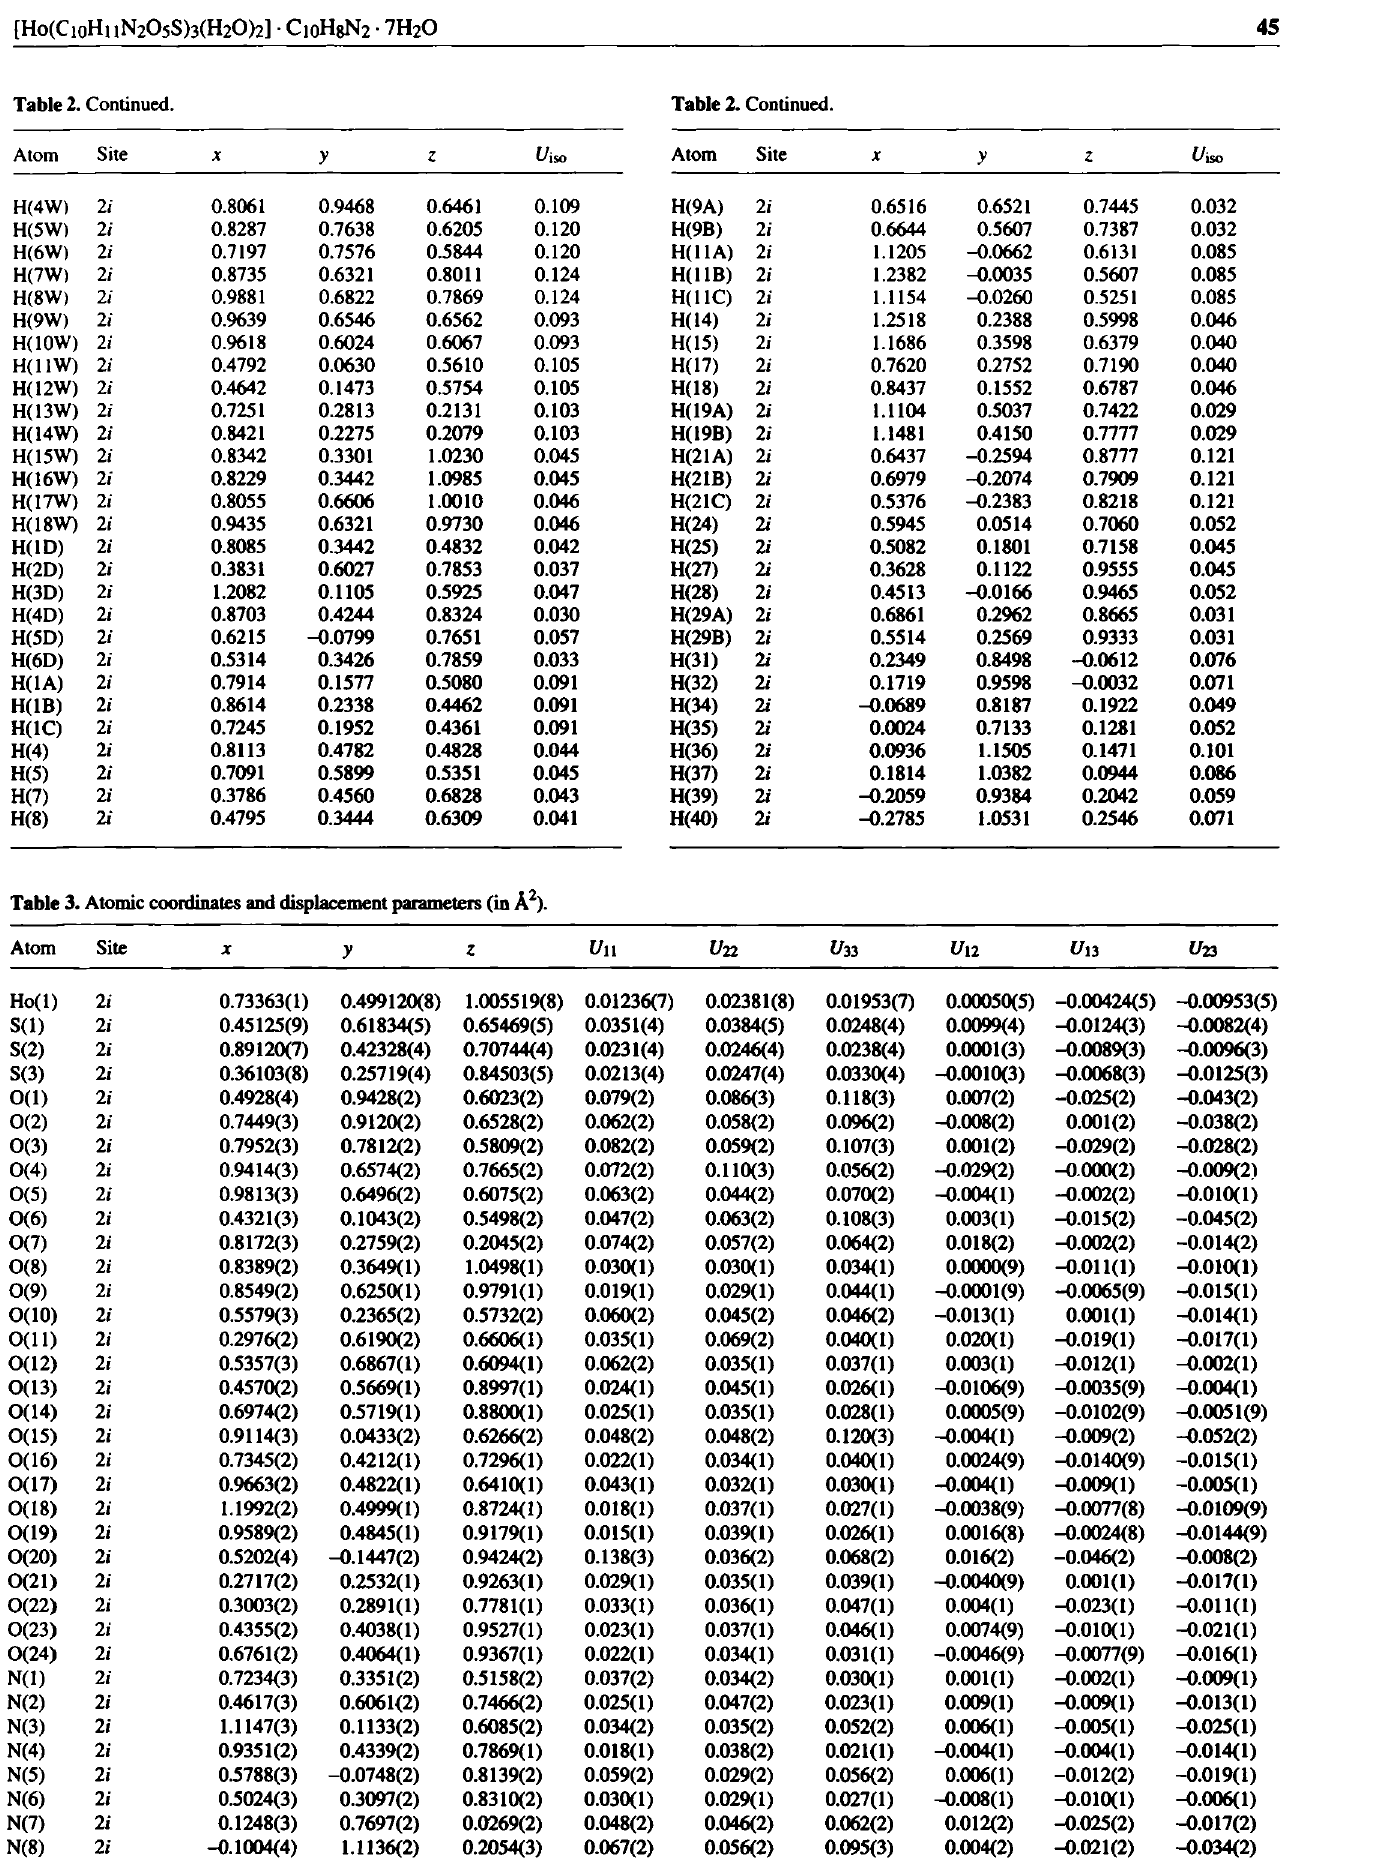
Table 3. Atomic coordinates and displacement parameters (in Â 2